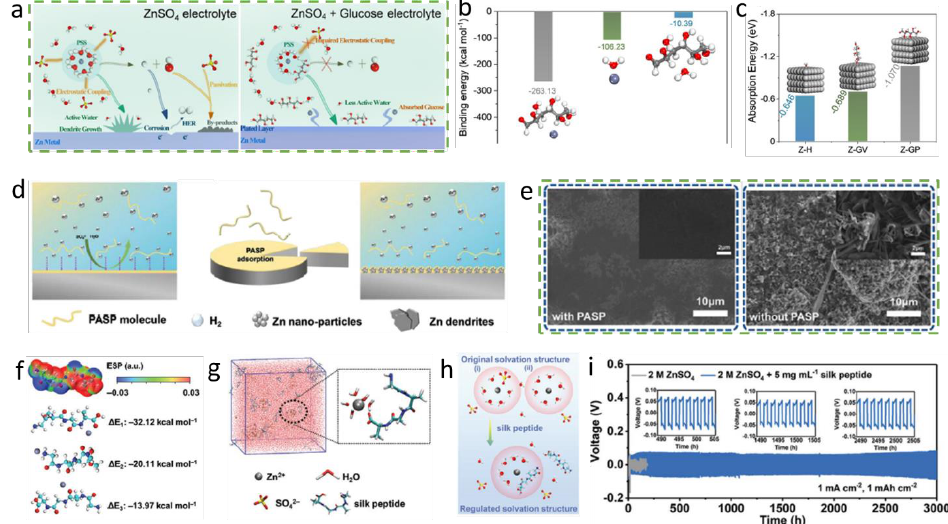
Figure 17. ( a ) Illustrations of Zn 2+ solvation structure and interfacial interaction between Zn anode surface and electrolyte under ZnSO 4 and ZnSO 4 -glucose electrolytes, ( b ) DFT calculation of Zn 2+ binding energies with glucose and water, and ( c ) comparison of absorption energies of H 2 O and glucose molecules on Zn (002) crystal plane, with insets showing absorbed models for different situations. (Reproduced with permission. [36] Copyright 2021, John Wiley & Son). ( d ) Schematic illustration for the Zn deposition process in the electrolyte with PASP additive and ( e ) SEM images of the surface of the Zn anode deposited at 1 mA cm −2 with a capacity of 1 mAh cm −2 with and without PASP additive. (Reproduced with permission. [193] Copyright 2022, Elsevier). ( f ) DFT calculations of binding energies between Zn 2+ and COOH (ΔE 1 ), NH 2 (ΔE 2 ), and CO- NH (ΔE 3 ) groups, respectively, on the silk peptide chain, ( g ) MD simulations for Zn 2+ solvation structure in ZnSO 4 aqueous electrolyte containing silk peptide, ( h ) schematic illustration of Zn 2+ solvation structure with/without silk peptide, and ( i ) cycling performance of Zn-Zn symmetric cells using the ZnSO 4 aqueous electrolytes with/without silk peptide. (Reproduced with permission. [194] Copyright 2022, John Wiley & Son).